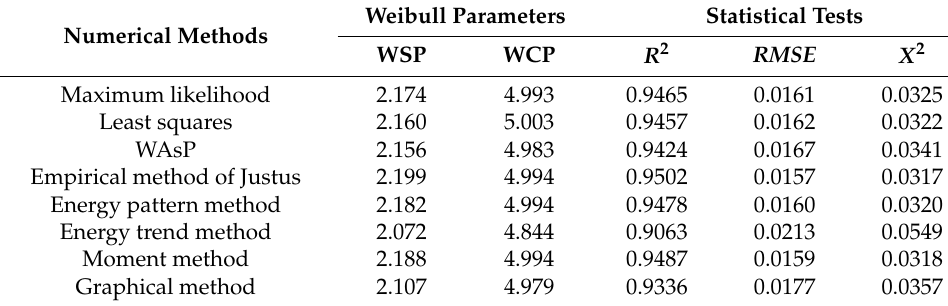
Table 5. Weibull parameters and statistical analysis for Jiwani.